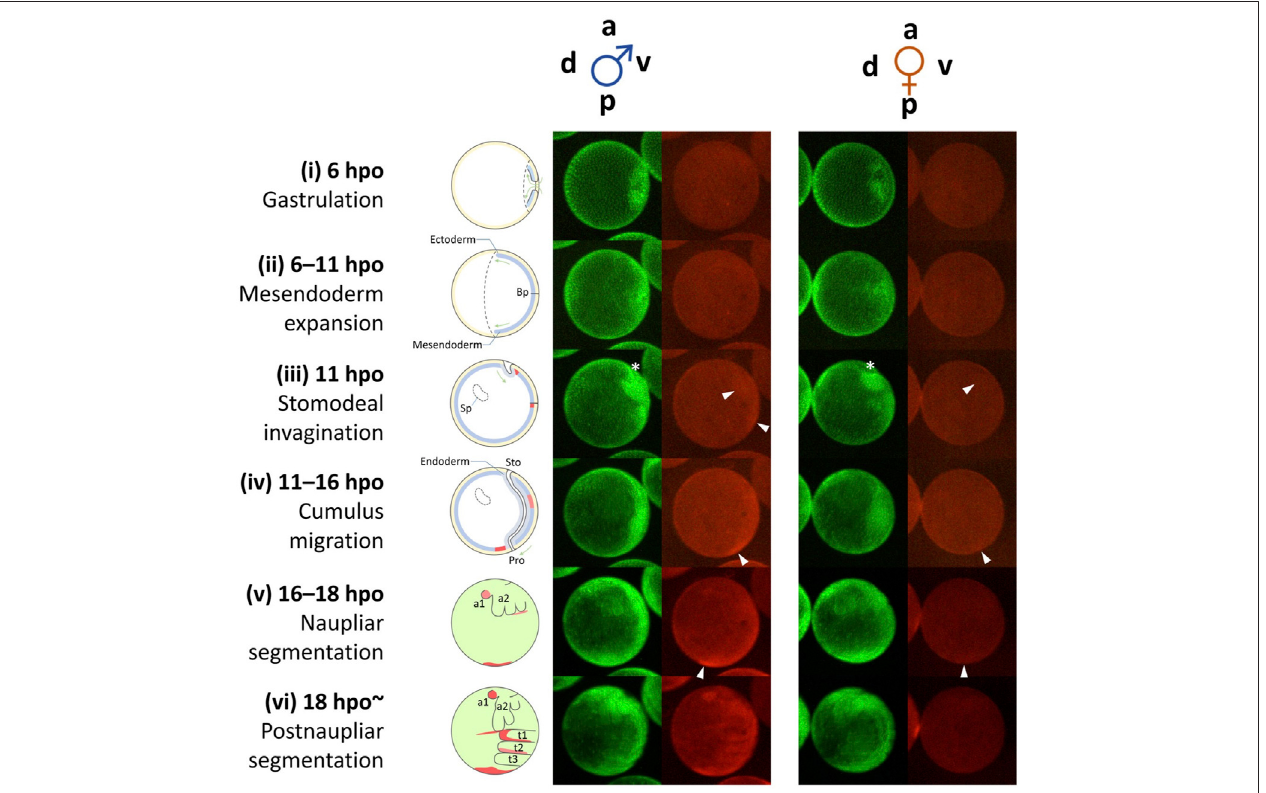
FIGURE 6 | Dynamic progression of Dsx1 -expressing cells during early embryogenesis from gastrulation until thoracic segmentation. Schematic diagrams on the left illustrate thesimpleanatomy ofthe embryos at the corresponding time points. Thediagrams from stages (i)to (iv) show images ofembryonic sections. The diagrams (v)and(vi)showsuper fi cialviewsofembryos.a,anterior;p,posterior; v,ventral;d,dorsal;Bp,blastopore;Sp,Scheitelplatten;Sto,stomodeum;Pro,proctodeum;t1 – 3, thoracicsegments;a1, fi rstantenna;a2,secondantenna;hpo,hourspostovulation.WhitearrowheadsindicatemCherry-expressingcellclustersthatmigrateinan anterior-to-posterior direction. An asterisk indicates the site of invagination. Adapted from Nong et al. (2017).